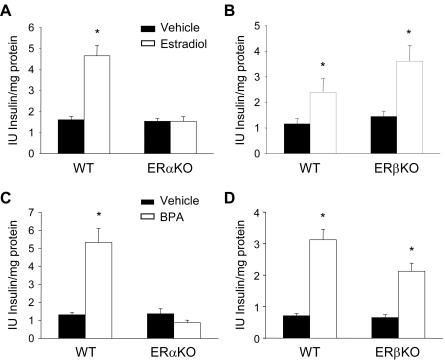
E2 effect on insulin content in ERαKO and ERβKO mice.(A) Insulin content obtained in cultured islets from wild-type and ERαKO mice exposed to either vehicle or 1 nM E2. Data obtained from 4 animals for experiments performed with wild-type mice and from 6 animals for experiments performed with KO mice, *p<0.001 compared to vehicle (B) Insulin content obtained in cultured islets from wild-type and ERβKO mice exposed to either vehicle or 1 nM E2. Data obtained from 2 animals for experiments performed with wild-type mice and 2 animals for experiments performed with KO mice, *p<0.05 compared to vehicle (C) Insulin content obtained in cultured islets from wild-type and ERαKO mice exposed to either vehicle or 1 nM BPA. Data from 4 animals for experiment performed with wild-type mice and 3 animals for experiment performed with KO mice, *p<0.001 compared to vehicle (D) Insulin content obtained in cultured islets from wild-type and ERβKO mice exposed to either vehicle or 1 nM BPA. Data from 4 animals for experiment performed with wt mice and 4 animals for experiment performed with KO mice, *p<0.001 compared to vehicle.